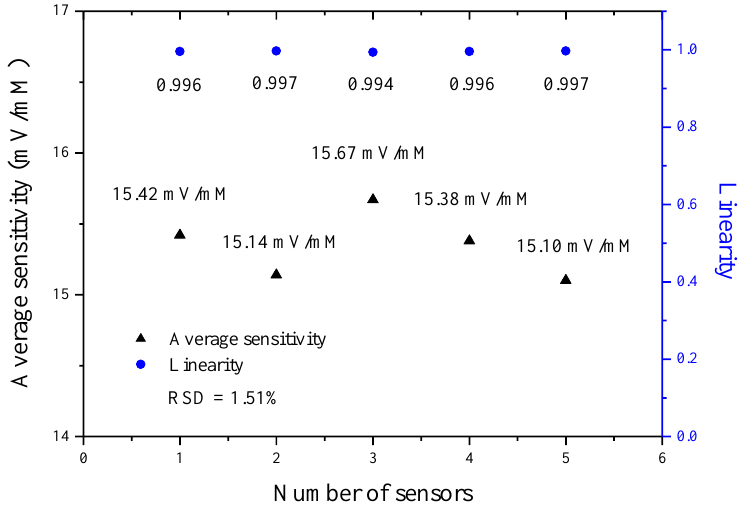
Figure 12. Average sensitivities and linearities of the five potentiometric arrayed glucose biosensors based on Nafion-GOx / GO / AZO over glucose concentrations ranging from 2 to 10 mM (number of sensors, N = 5). Table 3. Reproducibility of the five independent potentiometric arrayed glucose biosensors based on Nafion-GOx / GO / AZO over glucose concentrations ranging from 2 to 10 mM (number of sensors, N = 5). Number